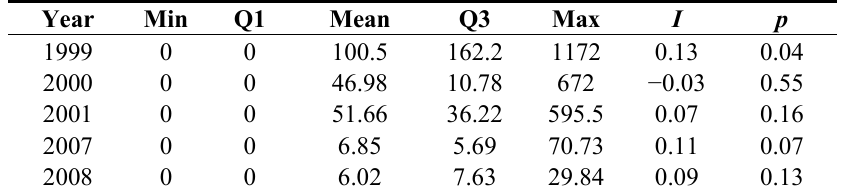
Table 1. Prevalence (cases/10,000) of schistosomiasis and its global spatial autocorrelation in the mountainous area, China.